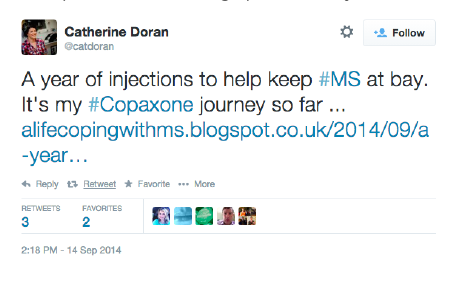
Figure 3. Example tweet from drug-specific